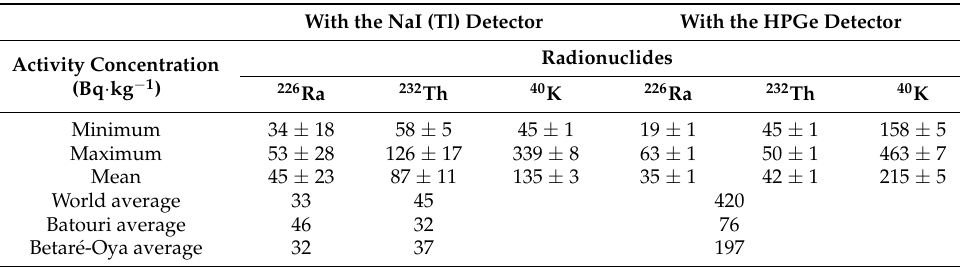
Table 3. Activity concentrations in soil samples of 226 Ra, 232 Th, and 40 K measured with the NaI (Tl) and HPGe detectors. With the NaI (Tl) Detector With the HPGe Detector Activity Concentration (Bq · kg − 1